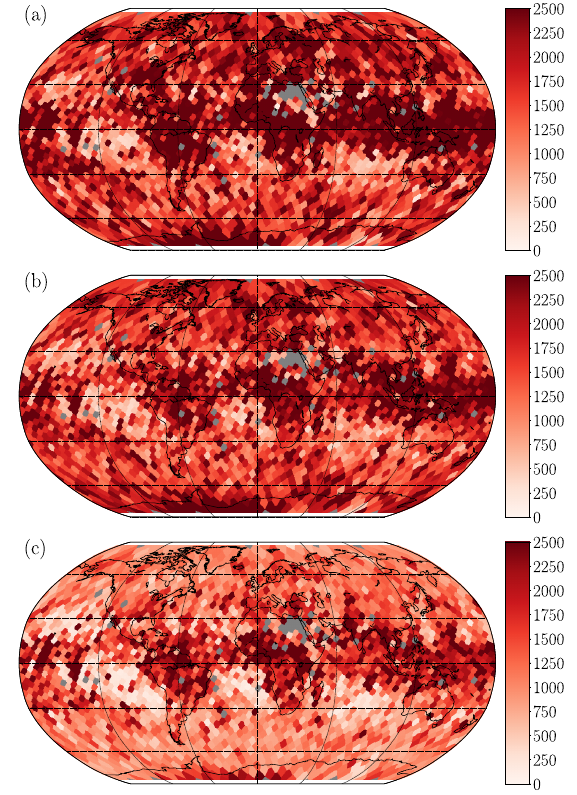
Figure 7. Mean absolute error in meters compared to CALIOP height. From the top (a) PPS-v2014, (b) MODIS-C6, and (c) NN- AVHRR. Results are calculated for bins evenly spread out 250km apart. Bins with fewer than 10 cloudy pixels are excluded (plotted in dark grey). The final validation and testing under development data (see Table 1) are included to get enough pixels.